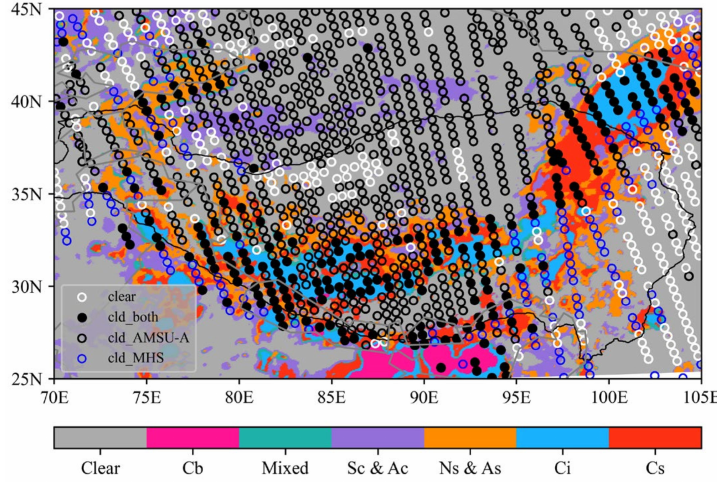
Figure 4. Clear-sky FOVs (white circles) and cloudy FOVs detected by the AMSU-A cloud index only (black circles), by the MHS cloud index only (blue circles), and by both cloud indices (black dots) along with the matched VISSR-II cloud classification products at the same moment—1200 UTC 12 August 2019 (AMSU-A cloud index >0.10 or MHS cloud index >0.35 is the threshold to identify cloudy FOVs).